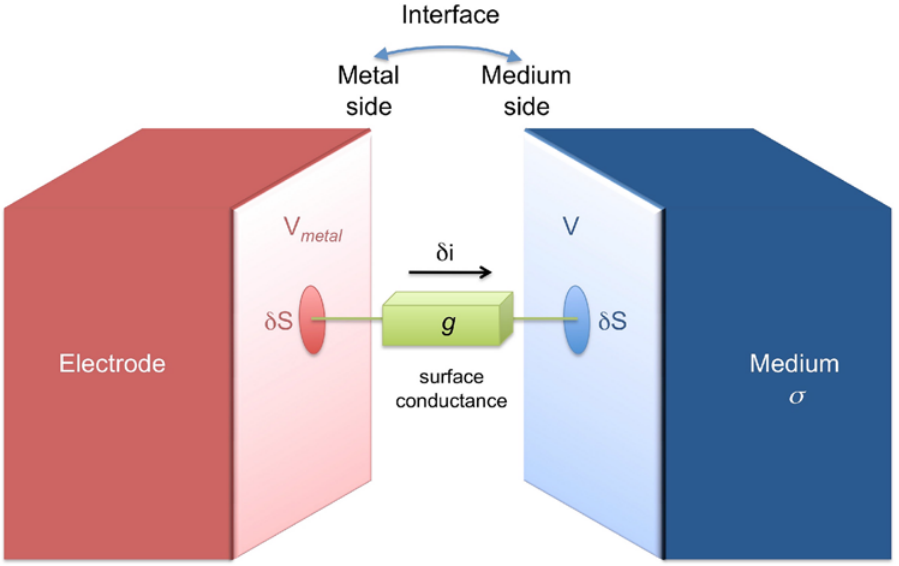
Figure 2. Schematic representation of the electrode/medium interface. During an electrical stimulation, a potential drop occurs between the metal and the medium sides of the interface. This drop can be modeled by a Robin boundary condition, taking into account the surface conductance of the interface ( g ) and the electrical conductivity of the medium ( s ). While the voltage on the metal side V metal is uniform, the electrical potential in the medium side ( V ) is allowed to vary over the electrode surface. Please, note here that even in the absence of stimulation, a junction potential exists at the interface. However, in this paper, this electrochemical equilibrium potential is assumed to be constant during the short time of the stimulation, and only the variations of the potential difference at the interface during the stimulation are considered.